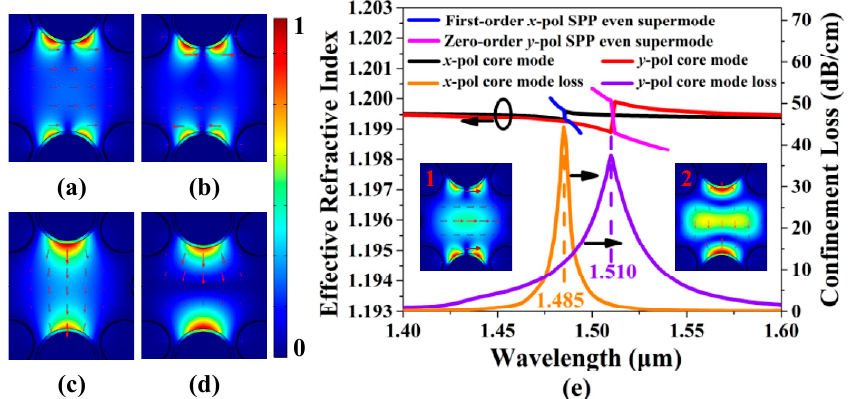
Figure 2. ( a , b ) The mode field distributions of the first-order x -pol SPP even and odd supermodes calculated at wavelength 1.480 μ m, respectively. ( c , d ) The mode field distributions of zero-order y -pol SPP even and odd supermodes calculated at wavelength 1.505 μ m, respectively. ( e ) The effective RI curves of the x -pol and y -pol core modes, and first-order x -pol and zero-order y -pol SPP supermodes and the confinement loss spectra of the x -pol and y -pol core modes when the RI of the filled analyte is 1.20. The inserts 1 and 2 show the mode field distributions of the x -pol and y -pol core modes calculated at the corresponding resonance wavelengths 1.485 and 1.510 μ m, respectively.